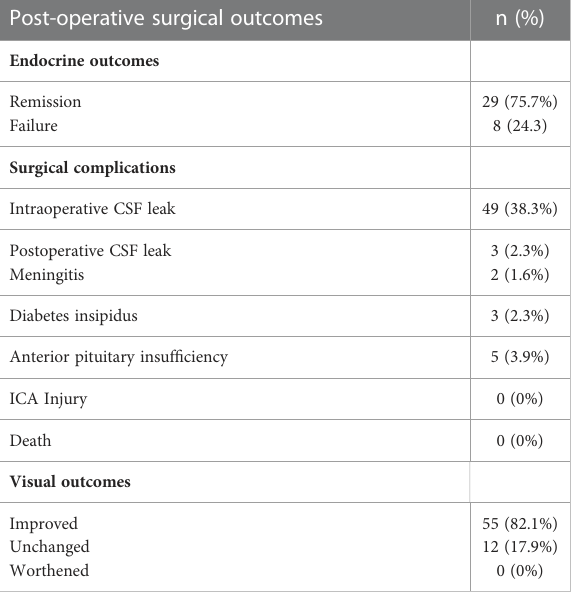
TABLE 2 Post-operative surgical